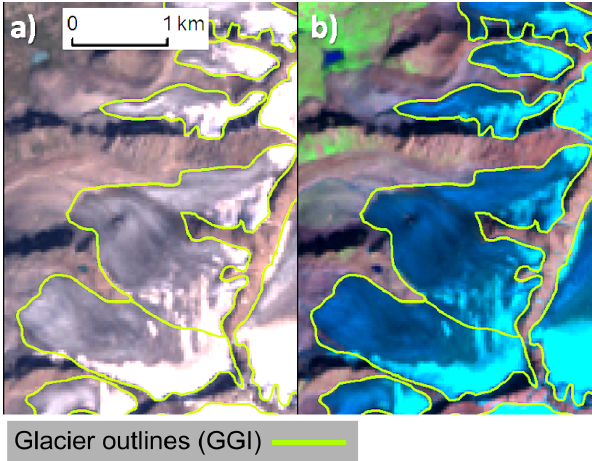
Figure 6. Thinly dust-covered glaciers located at 42.316 ◦ N, 78.833 ◦ E (path 148 row 31). Identification of such glaciers is problematic (i.e. they show only black surfaces) using true-colour (bands 3, 2, and 1 as RGB) composite imagery (a) but relatively straightforward using false-colour (bands 7, 4, and 2 as RGB) com- posite imagery (b) . Background imagery was acquired on 25 Au- gust 2002.